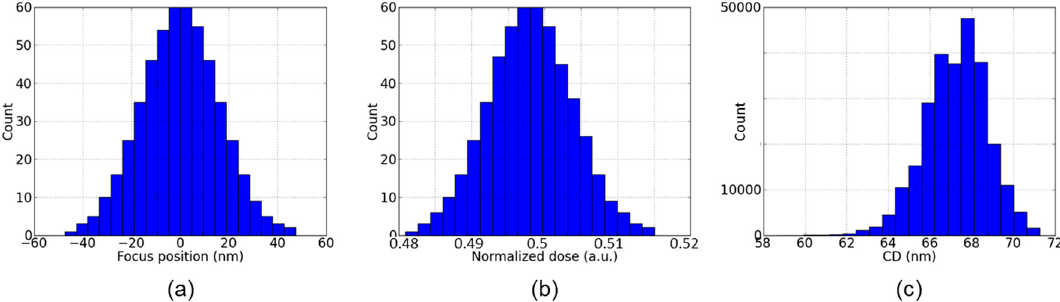
Figure 2. Impact of variations of focus and dose on a 193 nm dry lithography process with adapted illumination for 65 nm lines/130 nm spaces (duty factor 1:2): Variation of ( a ) focus and ( b ) threshold considered; ( c ) resulting variation of CD.